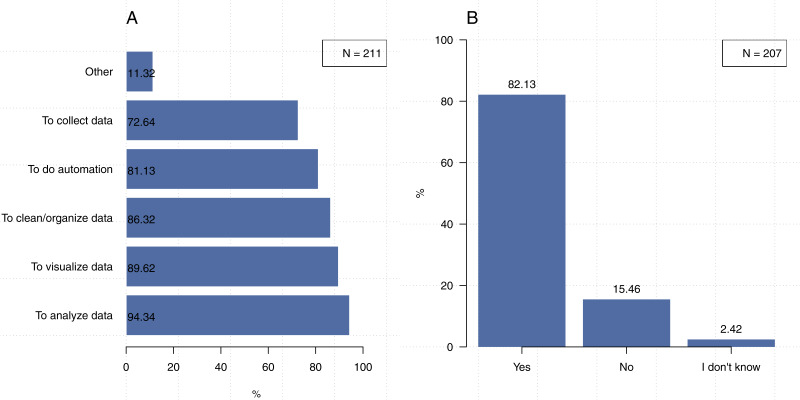
The purpose of using research software.Note that the first question could be answered with more than one choice. (A) How do you use code or software? (B) Have you ever repurposed your code or software?